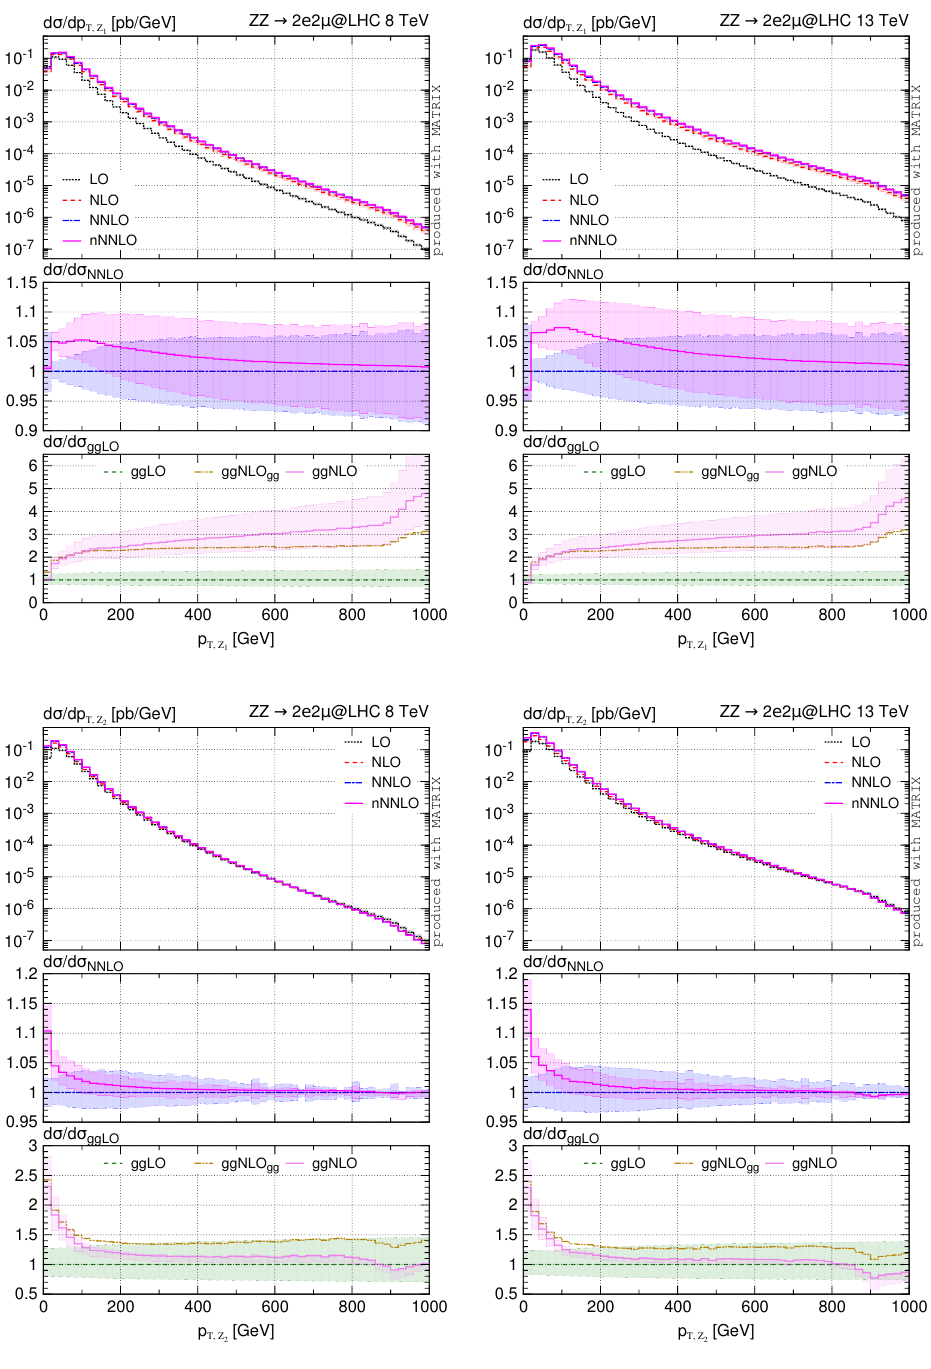
Figure 8 . Transverse-momentum spectra of the leading (top) and subleading (bottom) Z boson at 8 TeV (left) and 13 TeV